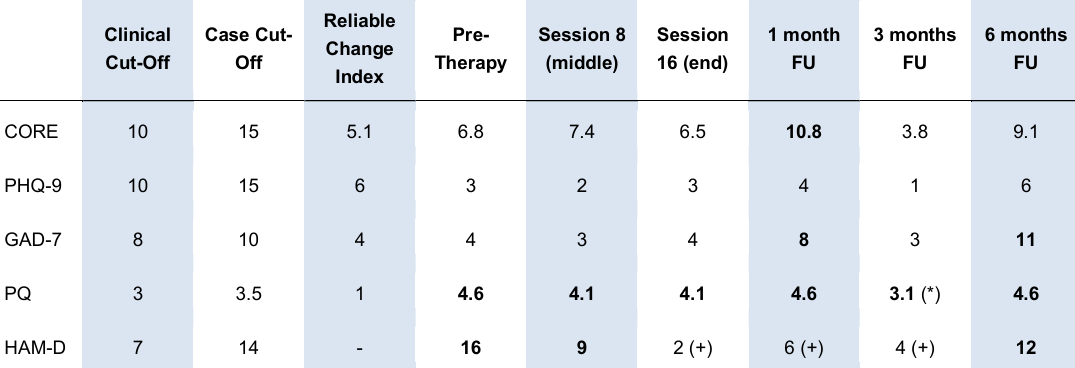
Table 1: Penelope’s Quantitative Outcome Measure Note. Values in bold are within clinical range; + indicates clinically significant change (CS). * indicates reliable change (RCI). CORE = Clinical Outcomes in Routine Evaluation-Outcome Measure (Evans et al., 2000). PHQ-9 Patient Health Questionnaire 9-item for depression (Spitzer, Kroenke & Williams, 1999) GAD-7 = Generalized Anxiety Disorder 7-item (Spitzer, Kroenke, Williams, & Löwe, 2006). PQ = Personal Questionnaire (Elliott, Shapiro, & Mack, 1999). HAM-D = Hamilton Depression Rating Scale (Hamilton, 1960). FU = follow-up.